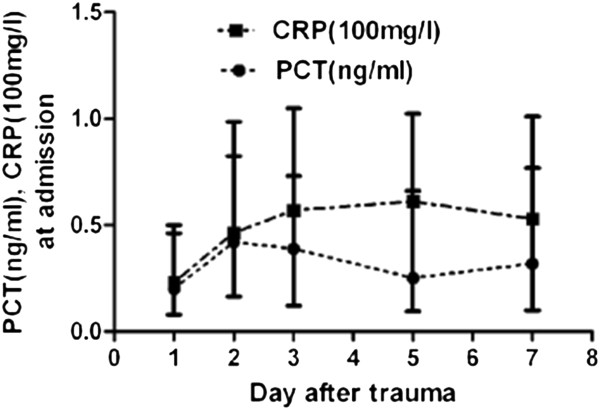
Serum levels of procalcitonin (PCT) and C-reactive protein (CRP) in patients with neurotrauma. Time course of induction (median, quartiles).